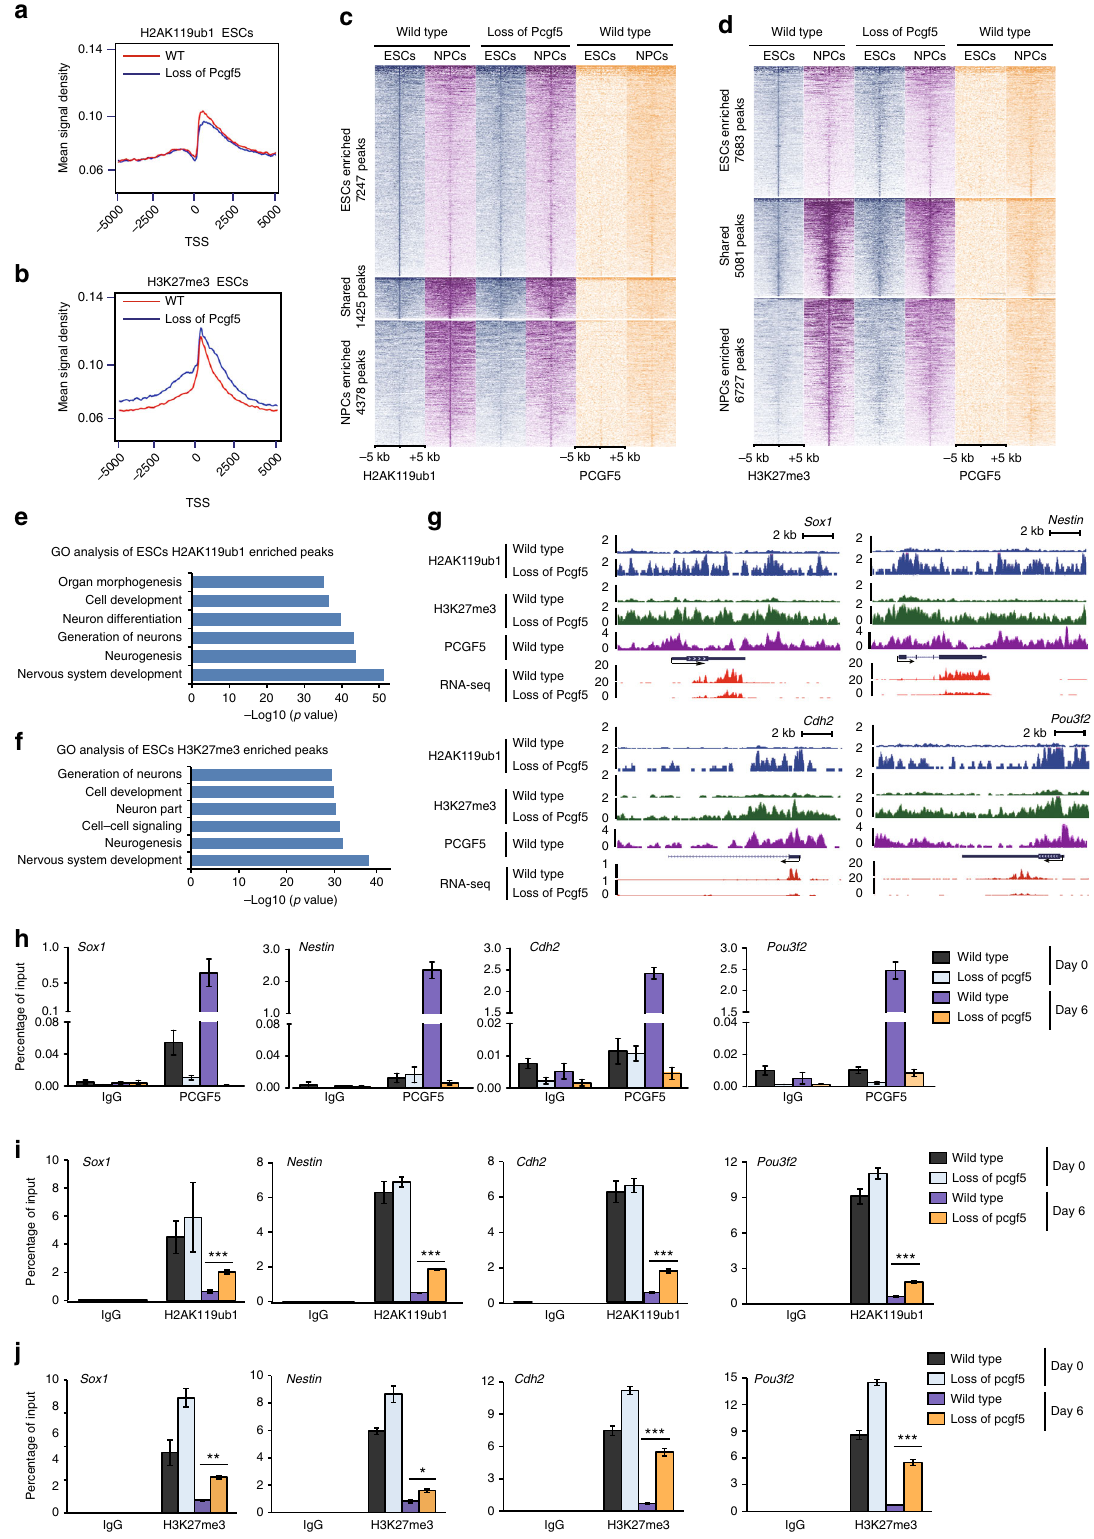
primers used in the qRT-PCR assays are listed in Supplementary Table 2. All the experiments were repeated for three times. In vitro ubiquitination assay . In vitro ubiquitin ligase reaction 26 was performed by incubating 1 μ l of ubiquitin activating enzyme E1 (Boston Biochem, 100nM),